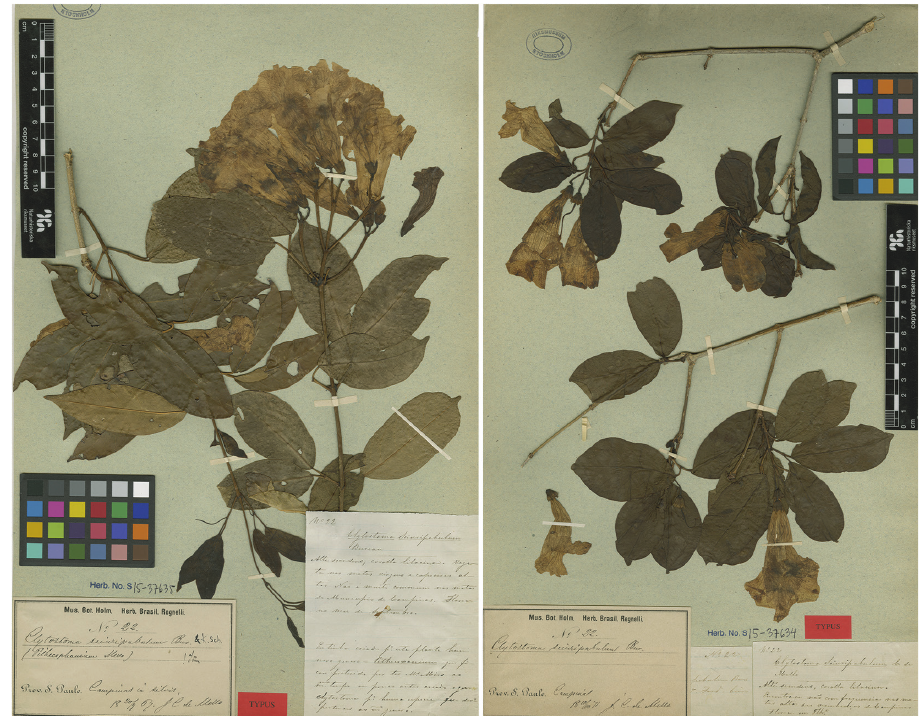
Figure 1. Clytostoma sciuripabulum Hovel. S15-37635, and S15-37634 (Neotype). Copyright of